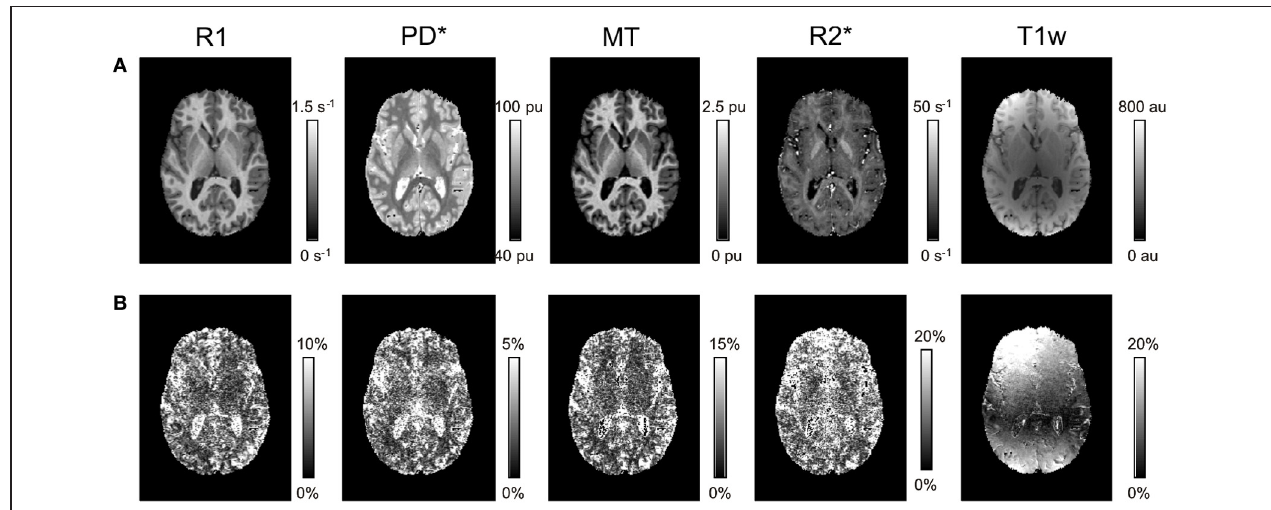
Table 1 | Group mean and standard deviation of parameter values and T1w image intensity in different ROIs. ROI R1 (1/s) PD * (p.u.) MT (p.u.) R2 * (1/s) T1w (a.u.) GM 0 . 609 ± 0 . 008 84 . 44 ± 1 . 87 0 . 794 ± 0 . 014 15 . 2 ± 0 . 4 319 ± 24 CN 0 . 683 ± 0 . 022 82 . 67 ± 1 . 64 0 . 836 ± 0 . 027 18 . 2 ± 1 . 2 WM 1 . 036 ± 0 . 036 68 . 35 ± 0 . 06 1 . 764 ± 0 . 066 21 . 0 ± 0 . 8 CC 1 . 158 ± 0 . 050 64 . 65 ± 0 . 86 1 . 978 ± 0 . 085 25 . 0 ± 0 . 5 414 ± 35 Mean ± standard deviation across five subjects. GM, gray matter; WM, white matter; CN, head of the caudate nucleus; CC, genu of the corpus callosum; R1, longitudinal relaxation rate; PD * , effective proton density; MT, magnetization transfer saturation; R2 * , effective transverse relaxation rate; T1w, signal intensity in T1w